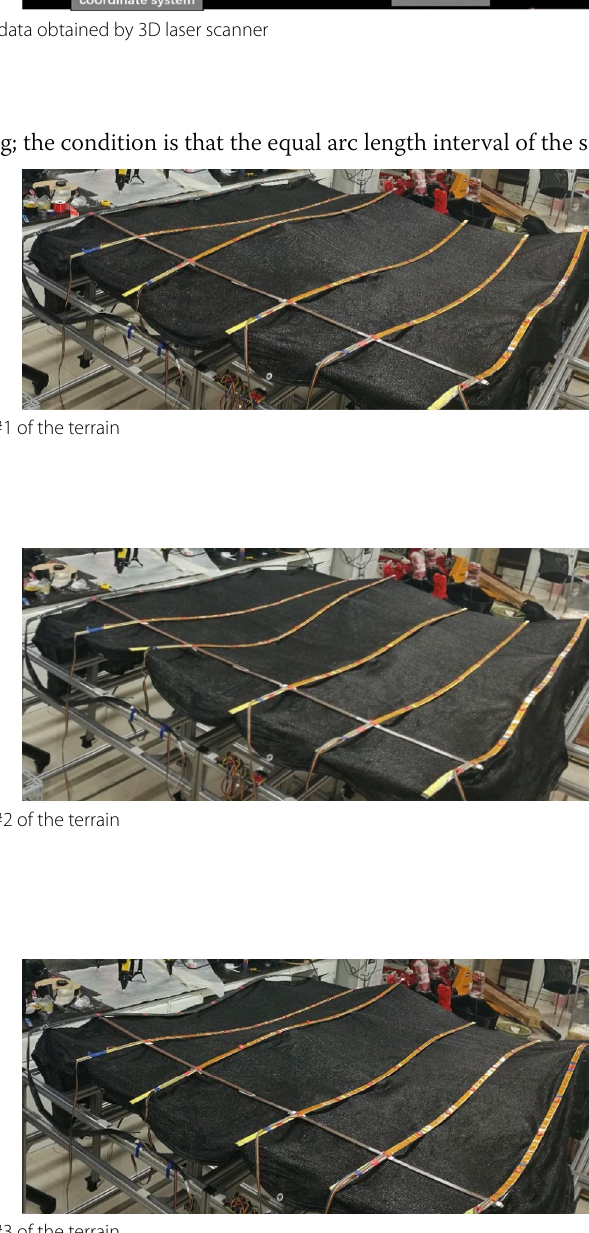
Fig. 14 Shape #3 of the